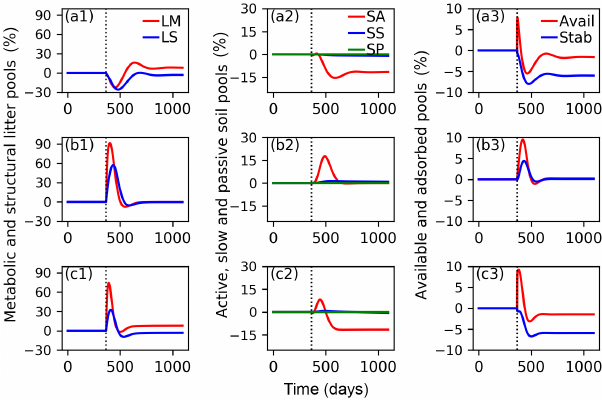
Figure 7. Relative changes of C in metabolic (LM) and structural (LS) litter pools (a1, b1, c1) ; in active (SA), slow (SS) and passive (SP) soil pools (a2, b2, c2) ; and in available (Avail) and absorbed (Absorb) pools (a3, b3, c3) for the CN-MFT3 model when temper- ature underwent a stepwise increase of 5K (a1, a2, a3) ; when FOM input doubles (b1, b2, b3) ; and when both a stepwise increase of 5K and FOM input doubling was implemented (c1, c2, c3) . The vertical black dotted line shows the time when the change of tem- perature and/or FOM input was